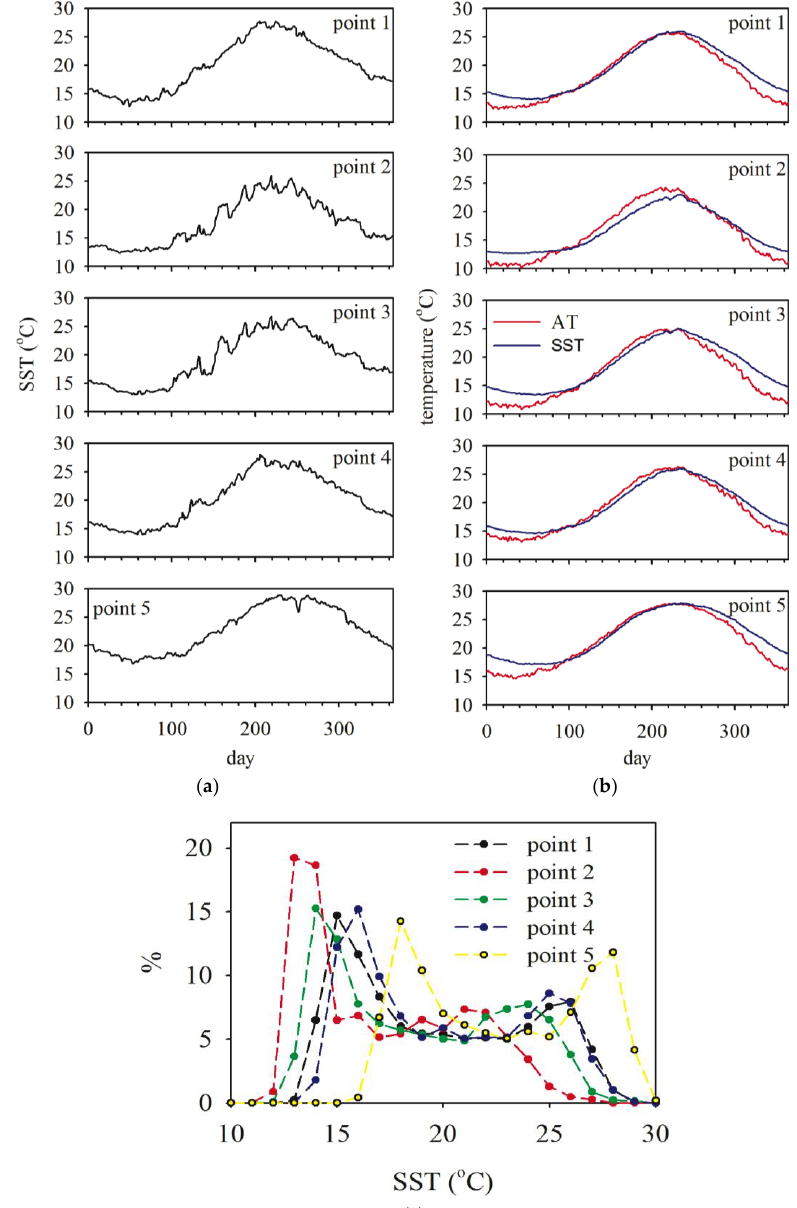
Figure 5. SST and AT data for 5 locations indicated in Figure 4a: ( a ) example time series of daily SST in year 2015; ( b ) comparison of the 36-year averaged daily time series of SST (blue line) and AT (red line); ( c ) frequency distributions of SST in 5 locations, based on the entire 36- years’ time series.